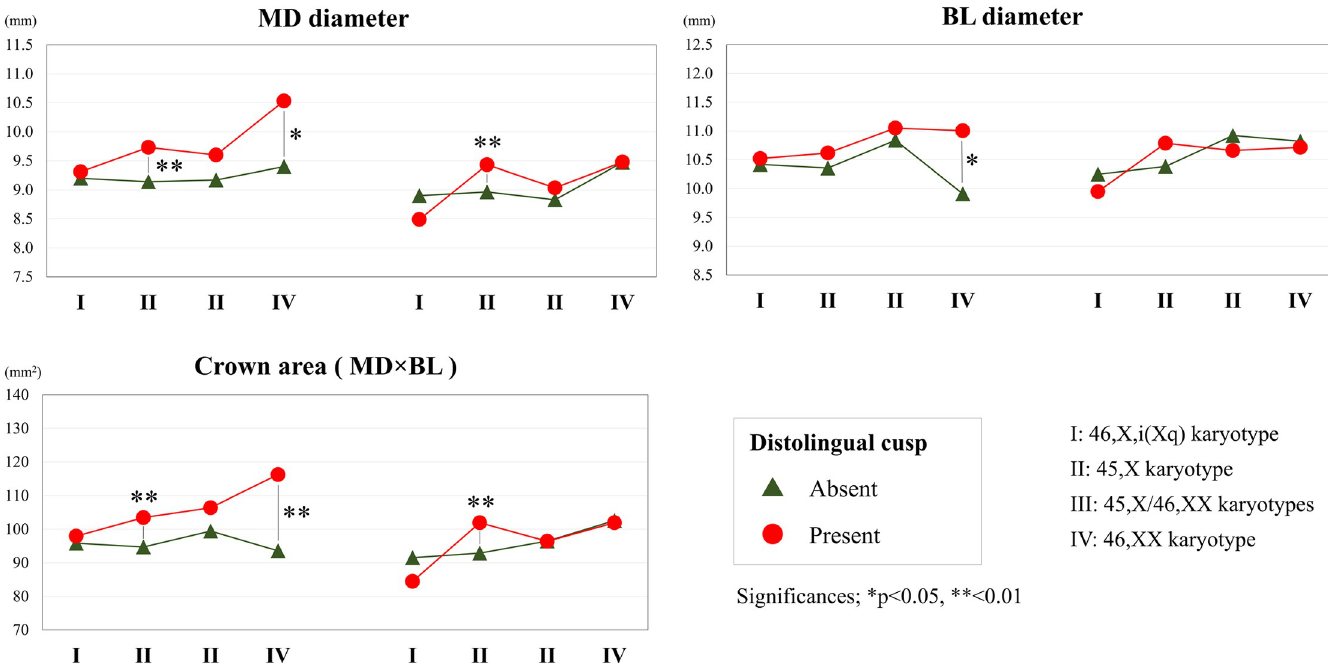
Fig 4. Mean tooth sizes (mesiodistal diameter, buccolingual diameter, crown area) and tooth shape changes of the distolingual cusp among females with Turner syndrome (46,X,i(Xq), 45,X/46,XX, and 45,X karyotypes) and population controls (46,XX karyotype). The t-test was used to assess the differences in tooth size between the absence and presence of the distolingual cusp. � p < 0.05, �� p < 0.01.